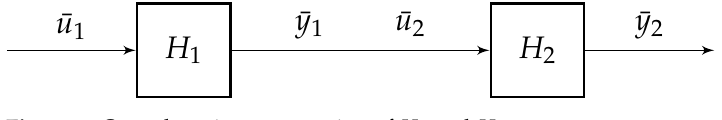
Figure 2. Open-loop interconnection of H 1 and H 2